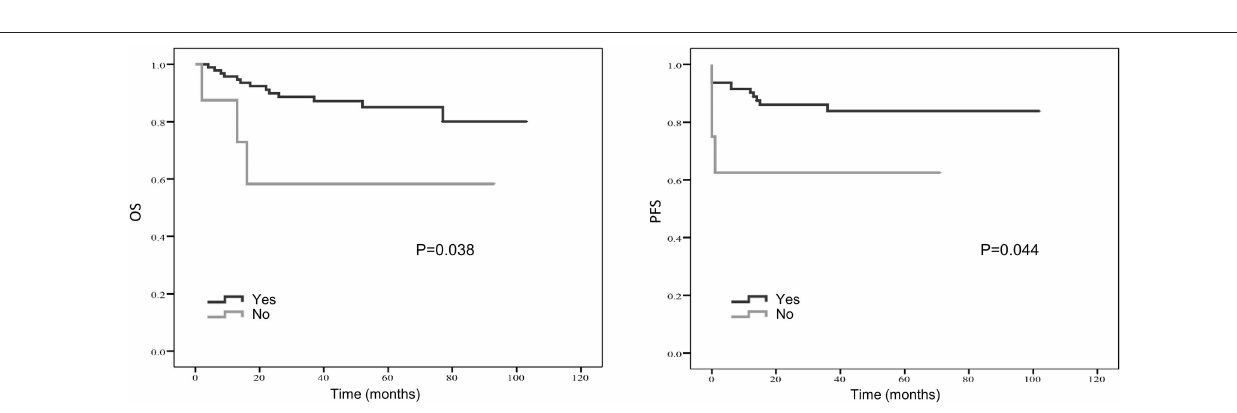
FIGURE 5 | Kaplan-Meier estimates of overall survival (OS) and progression-free survival (PFS) probability according to whether surgery was